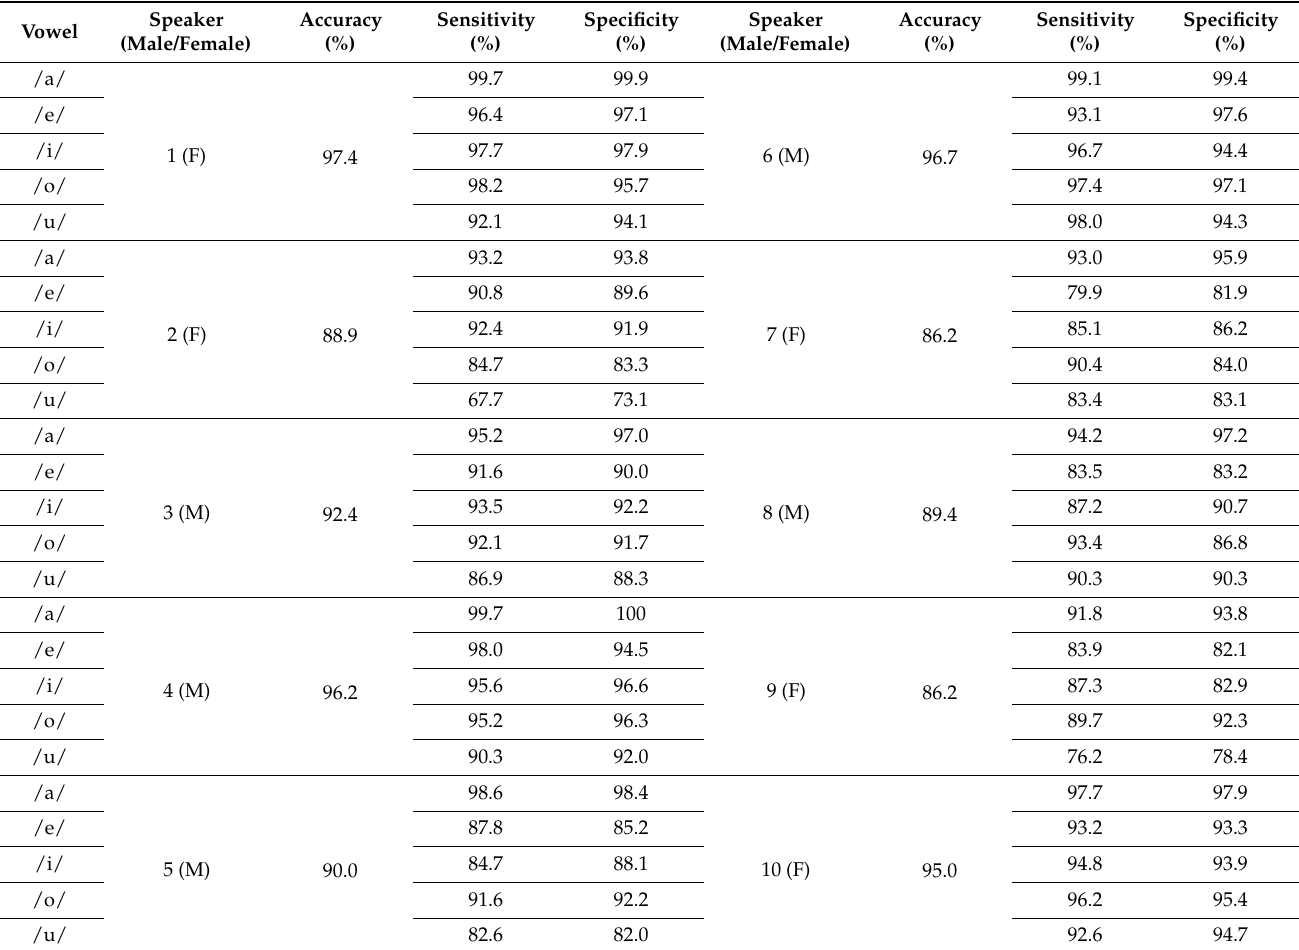
Table 3. Results of the ANN metrics per speaker and 30 neurons in the hidden